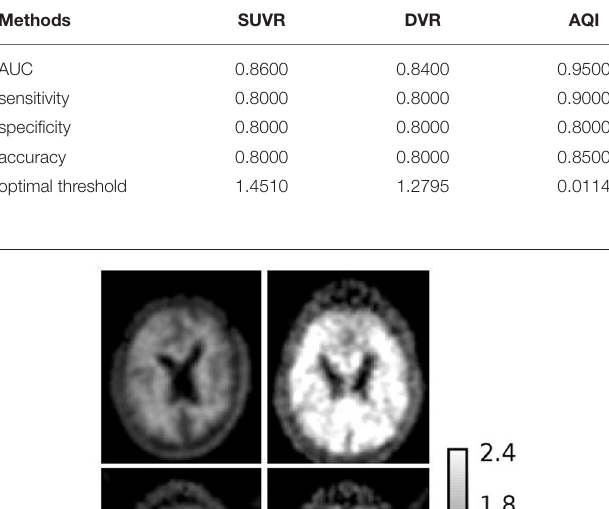
TABLE 3 | The classification performance of SUVR, DVR, and AQI on testing set.